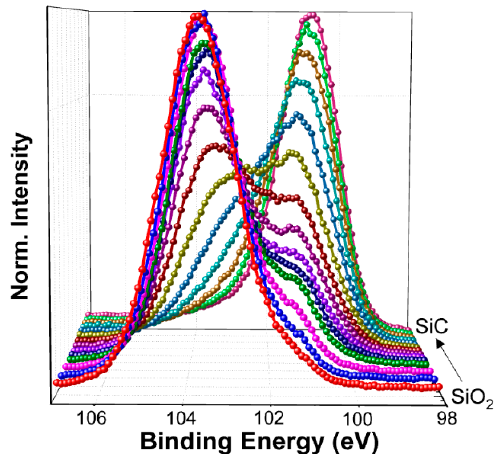
Figure 7. Si 2p core level X-rays photoelectron spectroscopy (XPS) spectra taken from the different depths of the transition of the sample without irradiation.